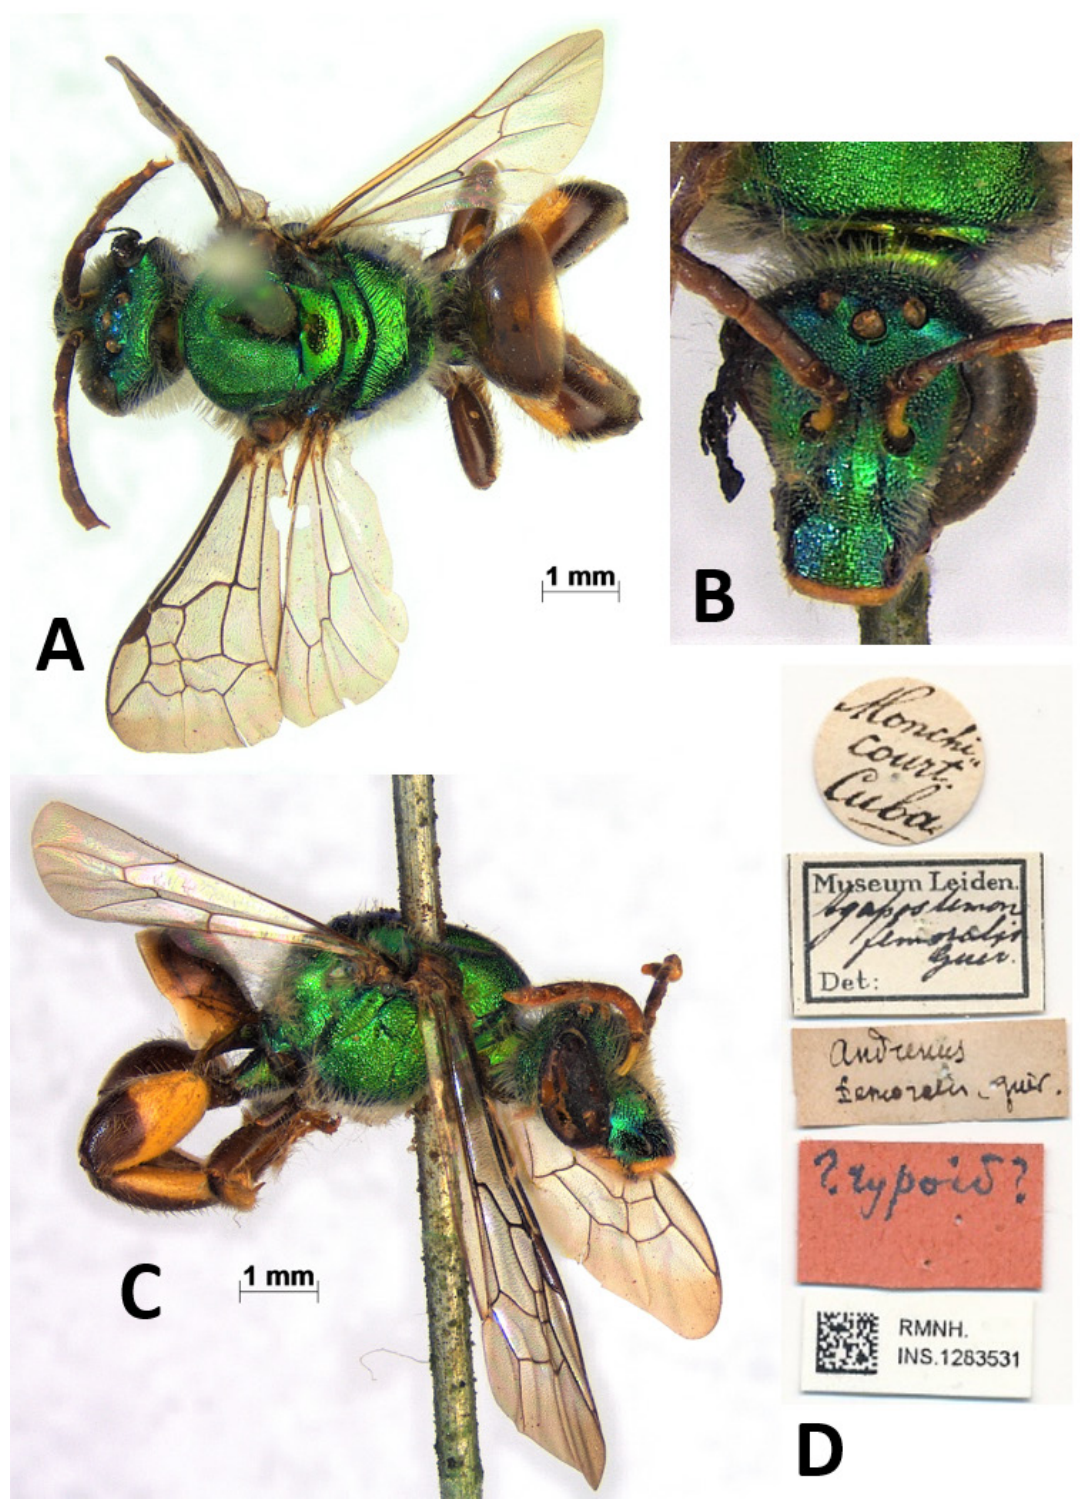
Fig. 3. Agapostemon femoralis Guérin-Méneville, 1844, the type species for the genus Agapostemon Guérin-Méneville, 1844. Lectotype (designated here), ♂ (RMNH.INS.1283531). A . Dorsal view. B . Face. C . Lateral view. D . Associated labels. Photos by F. Bakker, Naturalis Biodiversity